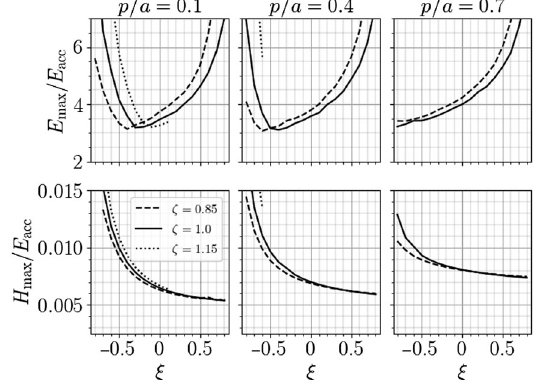
FIG. 11. Normalized peak surface E (V m − 1 ) and H (A m − 1 ) fields of the unequal radii corrugation geometry for aperture ratio a= λ ¼ 0 . 60 and ζ ¼ 0 . 85 (dashed), ζ ¼ 1 . 0 (solid), and ζ ¼ 1 . 15 (dotted).